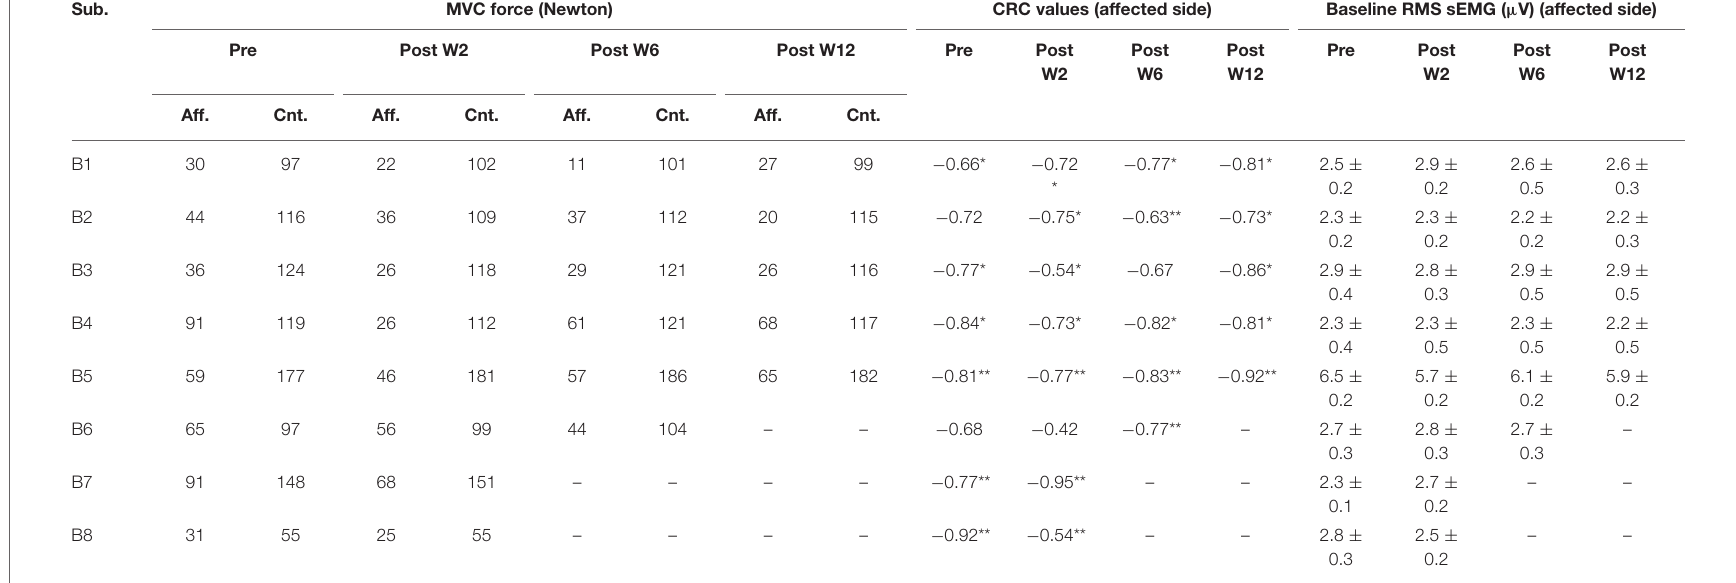
* Indicate p < 0.05, ** indicates p < 0.001 and, – indicates the unavailable